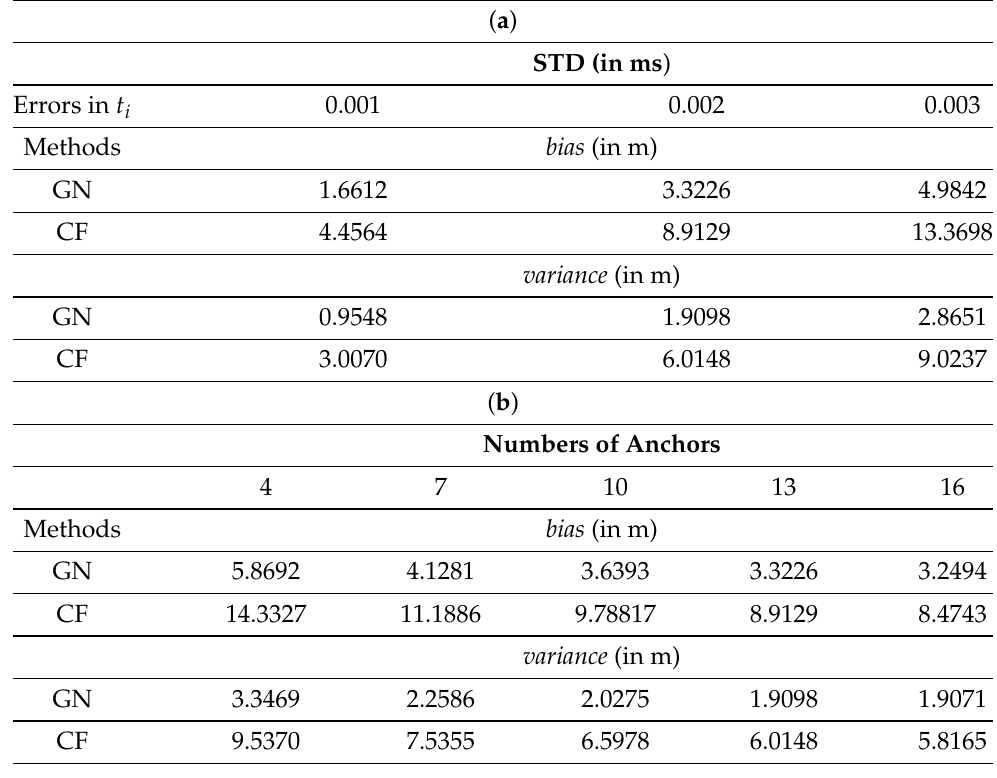
Table 1. Comparison between the CF and the GN method with varying noise level and number of anchors. Table ( a ) shows the effect of increasing levels of i.i.d. Gaussian noise in t i measurements on the bias and the variance . In this case, 12 assistant anchors are take part in Time-Difference-of-Arrival (TDoA) measurements. Table ( b ) shows the effect of increasing number of anchors involved in localization on the two metrics. The assistant anchors are deployed symmetrically on a circle around the lead anchor at the origin and the noise in t i measurements are i.i.d. Gaussian with σ = 2.0 ms. The geometric configuration of the anchors and the sensors are shown in Figure